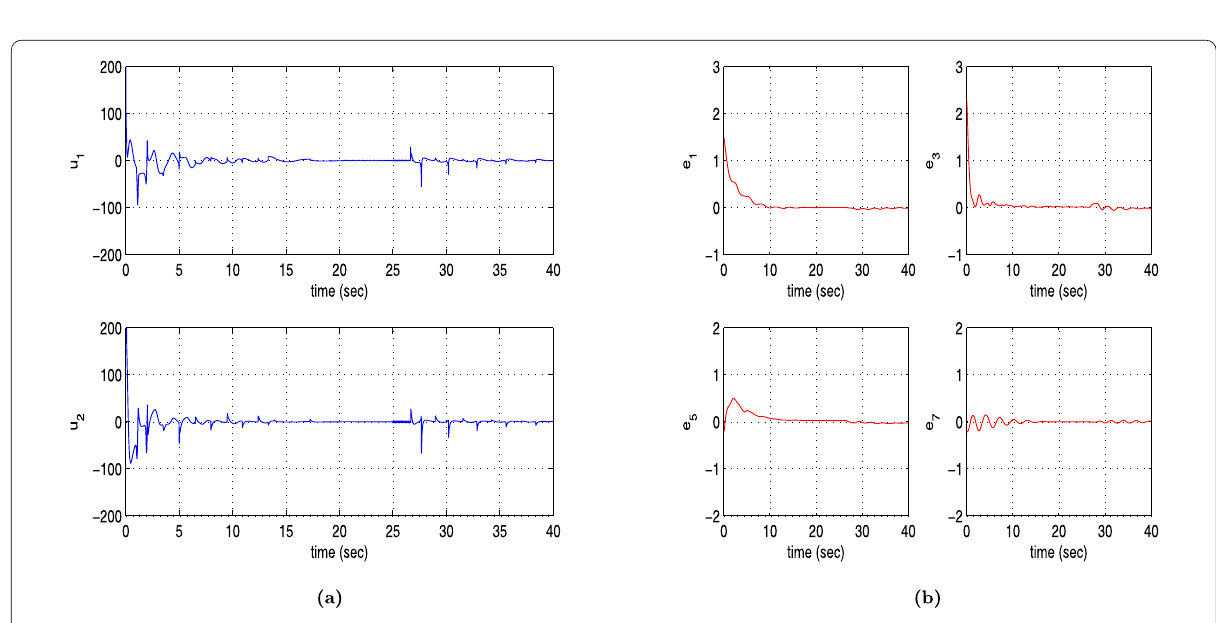
Figure 12 Tracking of setpoint 5 for the tower crane ( a ) control inputs u 1 , u 2 applied to crane, ( b ) tracking error variables e 1 , e 3 , e 5 , e 7 of the tower crane